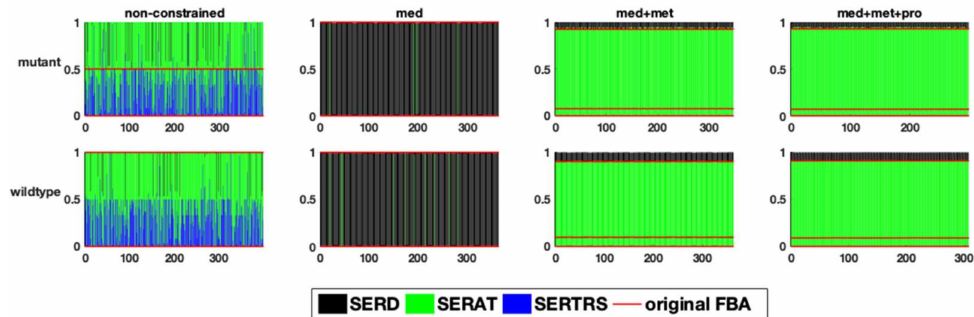
Figure 6. The relative flux distribution in the branching point of serine metabolism (y-axis) in response to one perturbation in each of the variable reactions (x-axis) in the two studied genome-scale models of E. faecalis , resulting in the production of acetyl serine, or seryl-tRNA or serine